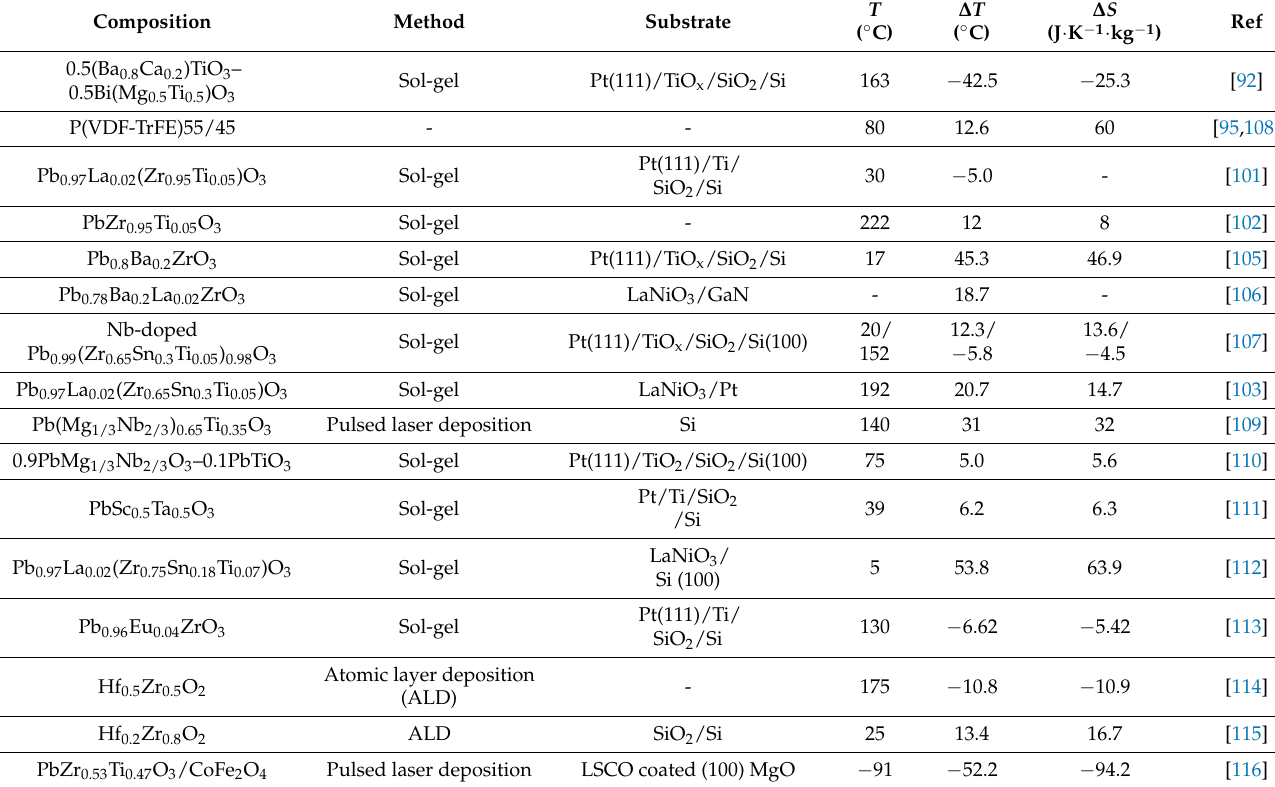
Table 1. Comparison of EC refrigeration of different thin